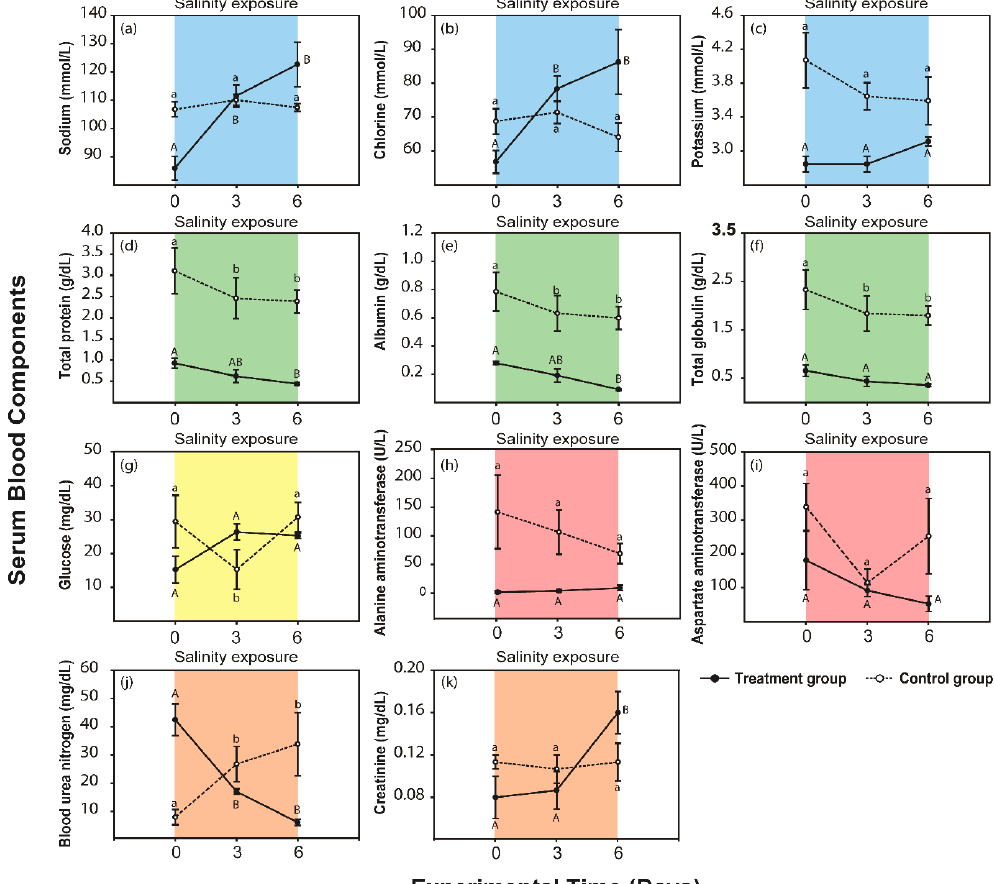
Figure 2. Graphs of 11 blood serum component levels (means ± standard error (SE)) after salinity exposure under the severe condition (black lines and points) and in the control group (dotted lines and white points) in P. nigromaculatus . The blue graphs depict the changes in serum electrolytes: ( a ) sodium (mmol/L) ( b ) chlorine (mmol/L), and ( c ) potassium (mmol/L). The green graphs depict the changes in serum protein: ( d ) total protein (g/dL), ( e ) albumin (g/dL), and ( f ) total globulin (g/dL). The yellow graph represents the change in a serum nutrient, ( g ) glucose (mg/dL). The red graphs depict the changes in liver function according to ( h ) alanine aminotransferase (ALT, U/L) and ( i ) aspartate aminotransferase (AST, U/L). The orange graphs depict the changes in renal function according to ( j ) blood urea nitrogen (BUN, mg/dL) and ( k ) creatinine (mg/dL). Significant differences ( p < 0.05) are indicated by capital letters in the experimental group and by lowercase letters in the control group according to Tukey’s post hoc tests.